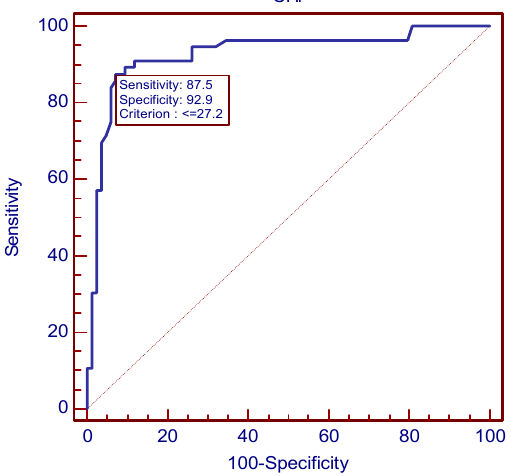
Figure 1. ROC curve of CHr diagnosing for IDA.